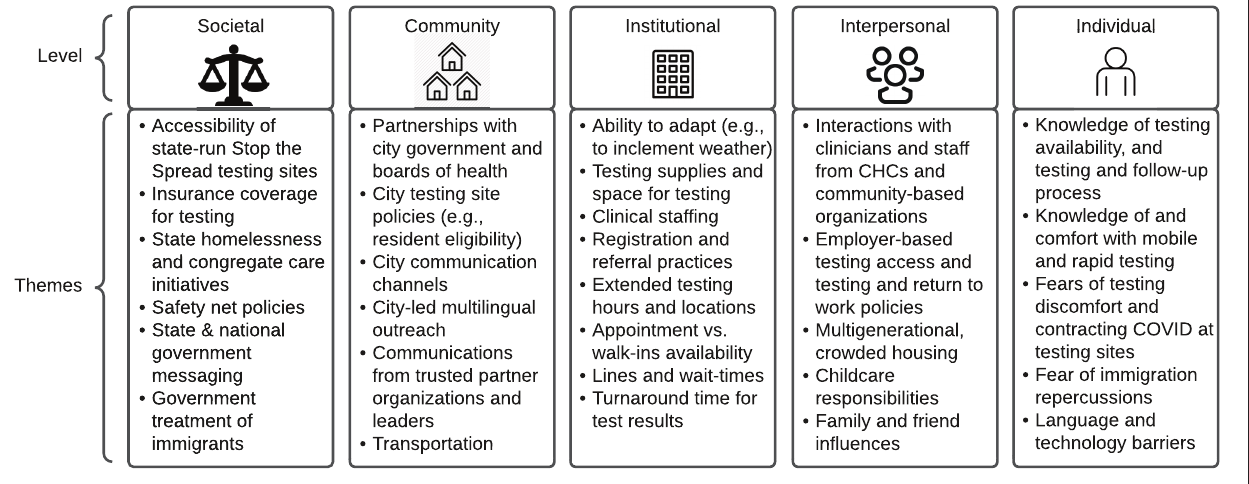
FIGURE 2 | COVID-19 testing barriers & facilitators themes organized by the social ecological